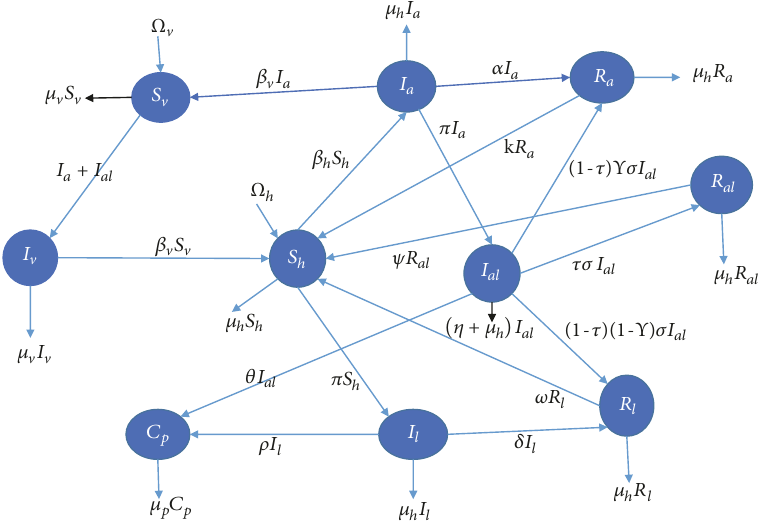
Figure 1: Flowchart for the coinfection